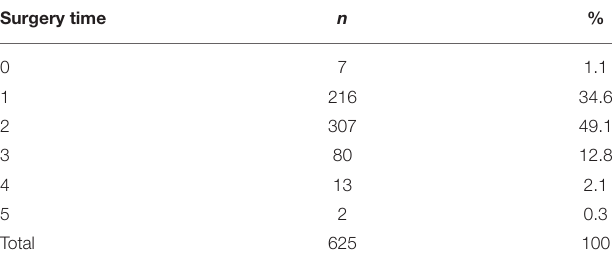
TABLE 5 | Surgery time of 625 eyes with severe